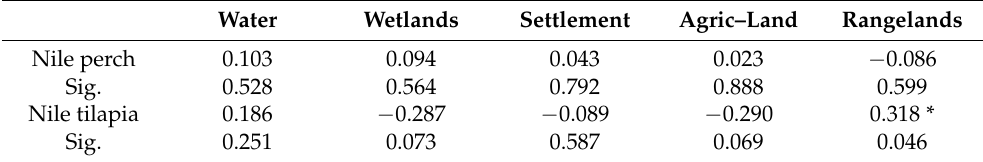
Table 5. Correlation between LULC classes and fish catches in Lake Kyoga catchment. Water Wetlands Settlement Agric – Land Rangelands